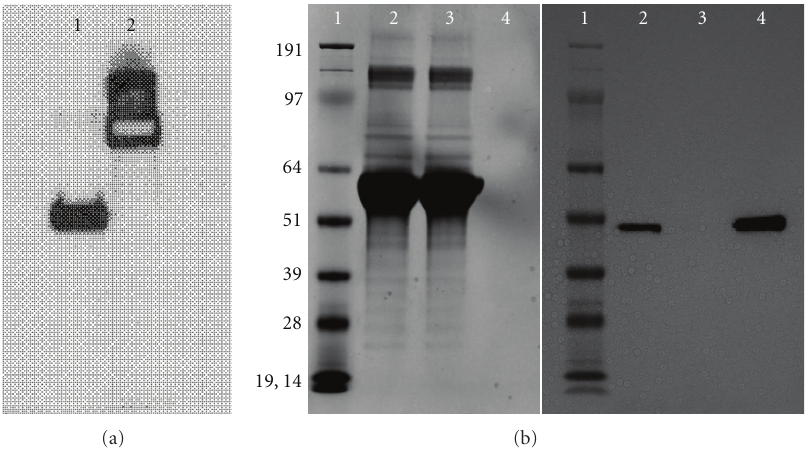
Figure 2: Expression and binding of engineered guinea pig soluble FcRn receptor. (a) This western blot confirms secretion of the guinea pig soluble FcRn by the Huh7 human liver cell line transiently transfected with pFUSE containing soluble FcRn. Shown are reduced (lane 1) and nonreduced (lane 2) guinea pig soluble receptor conjugated to Fc and blotted with rabbit anti-FCGRT polyclonal primary antibody specific for a FcRn alpha chain peptide partially conserved in the guinea pig sequence (see Figure 3(a) for the sequence). (b) Images of Coomassie stained gel (left) and a western blot demonstrating binding of the engineered guinea pig soluble FcRn receptor to a commercial human IgG column. Shown are the molecular weight markers (lane 1, with the respective mass shown), cell culture medium, column load (lane 2), column flow-through (lane 3), and column eluate (lane 4). The apparent molecular mass is lower than 50 kDa, whereas the theoretical molecular mass without glycosylation is ∼ 43 kDa. The column binding and elution was repeated three times with similar